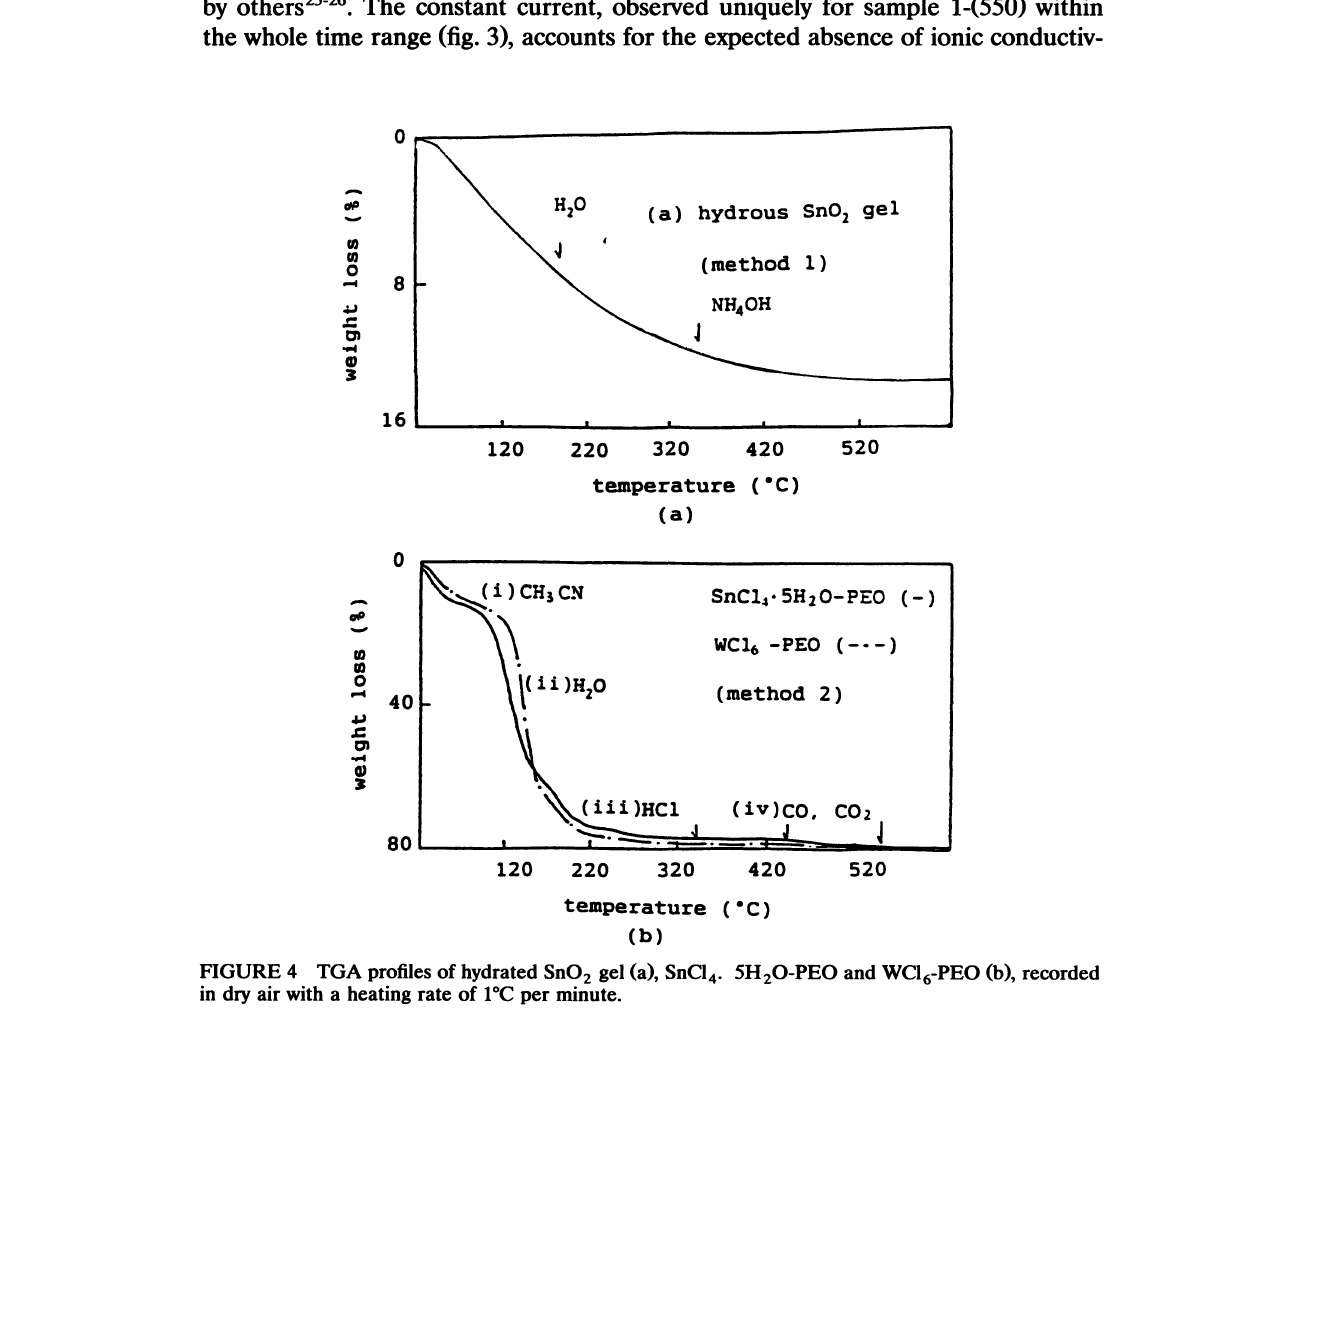
5H20-PEO and WCI6-PEO (b), recorded gel (a), SnCl 2 4.